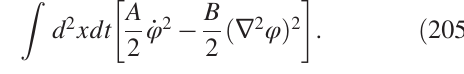
TABLE I. The stability condition for the symmetry-breaking ground state in d spatial dimensions, obtained by evaluating the scaling law of interactions and the infrared divergence for NGBs. T ¼ 0 T > 0 Only type- A